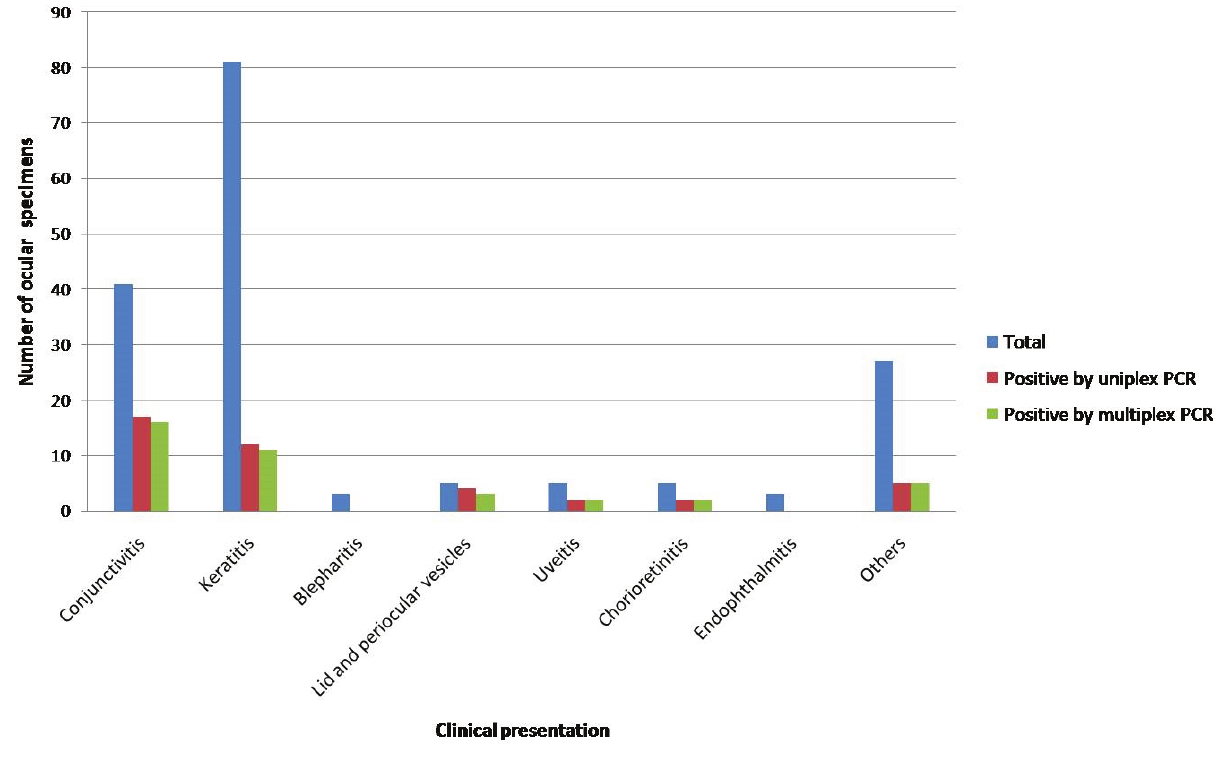
Figure 2. Distribution of specimens received and results of uniplex and multiplex PCRs from patients with different clinical